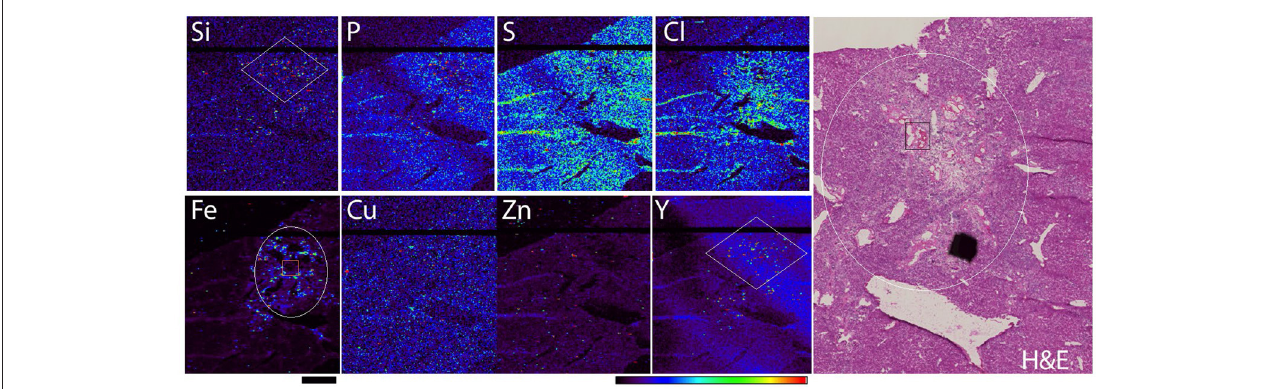
FIGURE 1 | Rat liver tissue elemental map obtained with 30 micron spot size scanning, X-ray energy 15 keV (Station 8BM-B). Elemental maps were obtained simultaneously while sample was moved by rapid raster scanning (so called: “fly scans”) through the X-ray beam. Scale bar − 2mm, color bar indicates elemental quantity as represented by false colors, from black (no signal) to red (highest signal). Hematoxylin and eosin (H&E) staining of the same region in one of the adjacent tissue sections is shown in the right-hand panel. White diamonds in Si and Y maps correspond to a TheraSpheres rich area; white circle indicates fibrotic area in Fe map and H&E image. Orange rectangle in Fe image and black rectangle in H&E image correspond to areas shown in Figure 2 (due to imaging setup, in Figure 2 these areas are horizontally flipped).